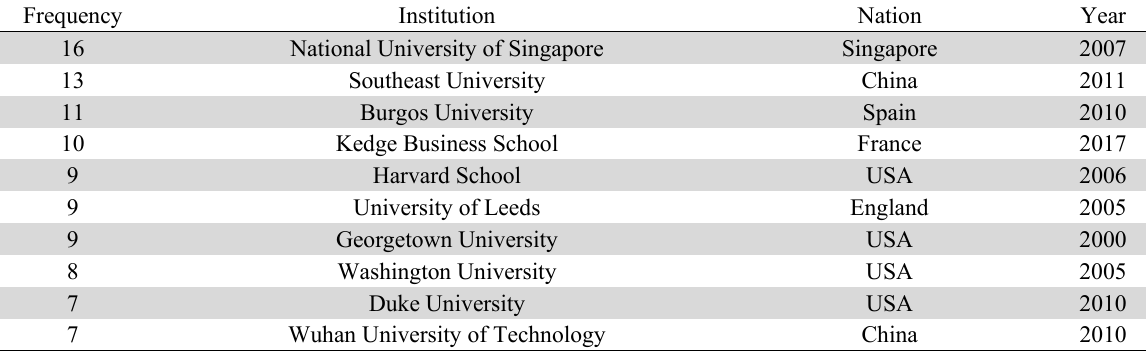
Fig. 4. Institution distribution of political risk related papers in WoS Top 10 institutions for political risk research